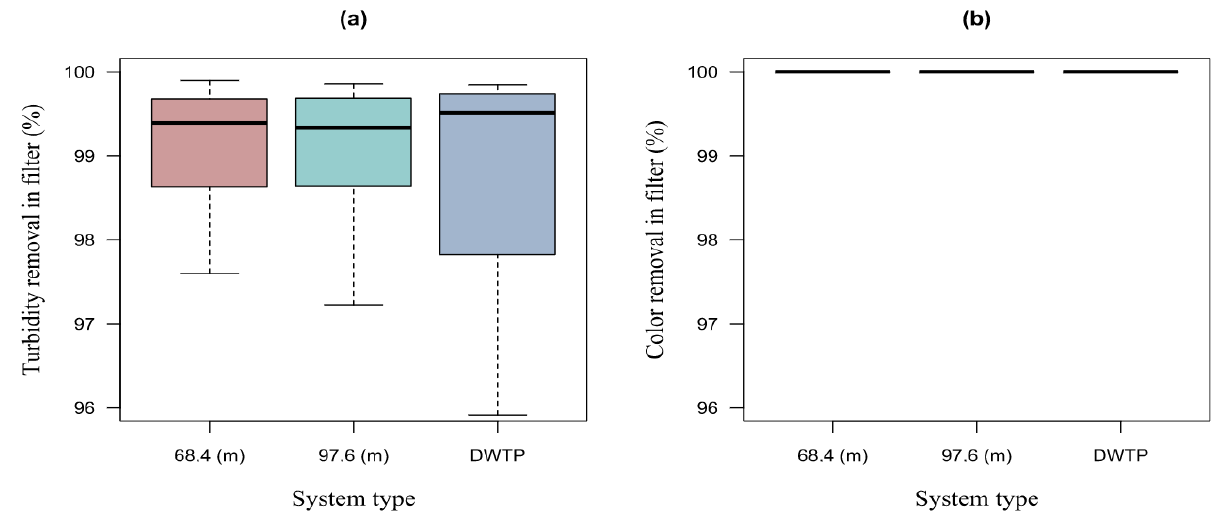
Figure 12. Average, maximum, and minimum values of the RE in the pilot filter with HTF of 68.4 m, with HTF of 97.6 m, and in the DWTP Bayas filter: ( a ) Turbidity and ( b ) color. The pink boxes correspond to the PTS with a 68.4m long tubular flocculator, the turquoise boxes correspond to the PTS with a 97.6m long tubular flocculator and the Light Steel Blue boxes correspond to the “Bayas” DWTP.